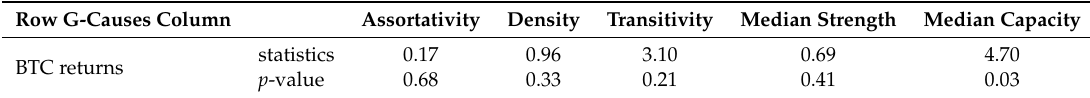
Table 4. Testing for the Granger-causality relationship: BTC returns vs. LN configuration. The table reports the results of the Toda–Yamamoto test (Toda and Yamamoto 1995) in which BTC returns are tested to verify whether they Granger-cause a list of topological indicators for the LN (reported in column). These topological indicators refer to respectively: the assortativity, the density, the transitivity, the median value of the nodes’ strength, and the median capacity of the